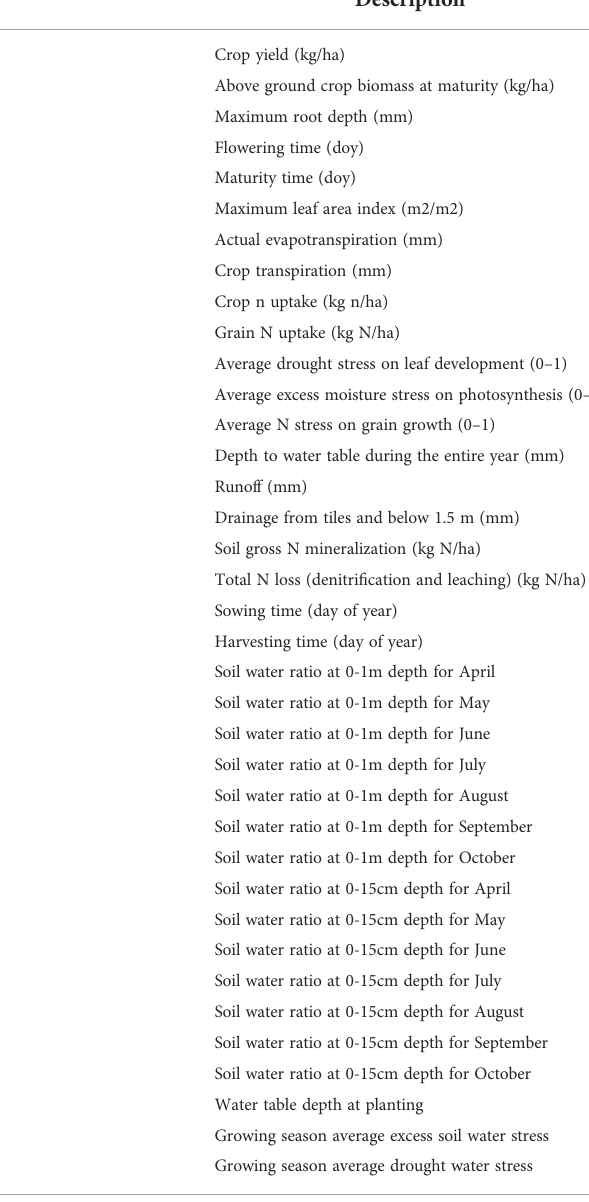
TABLE 1 APSIM model simulated variables considered as input features in the ML